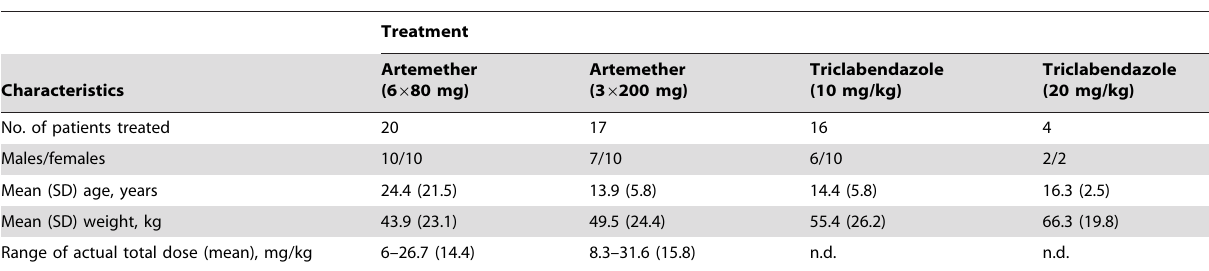
Table 1. Demographic baseline characteristics of 57 Fasciola- infected patients at inclusion.